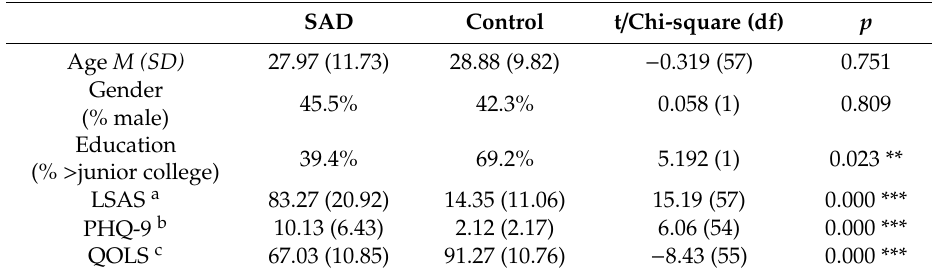
Table 1. Clinical characteristics and background variables of the social anxiety disorder (SAD) group and the control